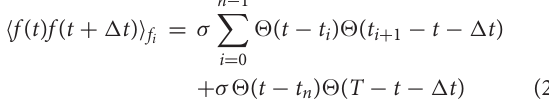
f i τ i and are i.i.d.s { } { }